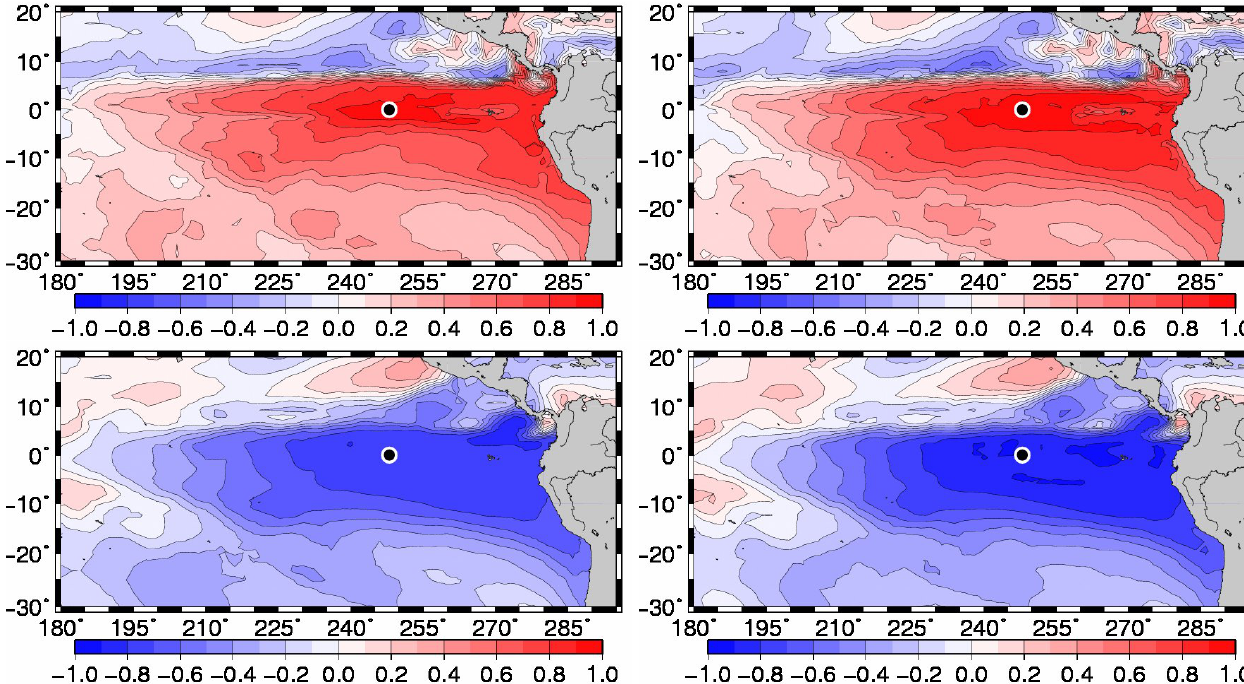
Fig. 4. MLD (top panels) and SST (bottom panels) horizontal correlation structure with respect to MLD at 114 ◦ W 0 ◦ N (Eastern Equatorial Pacific), without anamorphosis (left panels), and after local anamorphosis transformations (right panels).